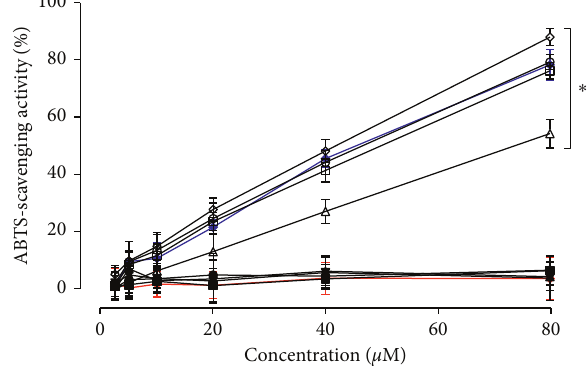
Figure 3: ABTS radical-scavenging activity of 4a ( ● ), 4b ( ■ ), 4c ( ▲ ), 4d ( ▼ ), 5a ( ◇ ), 5b ( ○ ), 5c ( □ ), 5d ( △ ), piperine ( ◆ ), and VC ( ◆ ). ∗ indicates a significant difference from the piperine group ( p < 0 . 05).